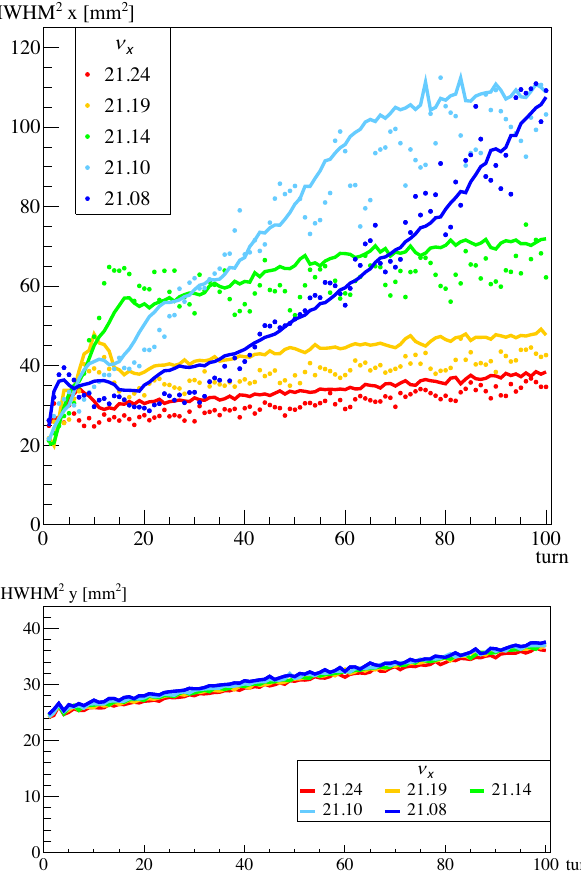
FIG. 7. Beam sizes in the NY21 experiment. The upper picture shows the horizontal beam sizes and the lower picture shows the vertical ones. Experimental results are shown as circles and simulation results are shown as lines. The color difference represents the difference in the vertical tune. The horizontal tunes were fixed to ν x ¼ 21 . 43